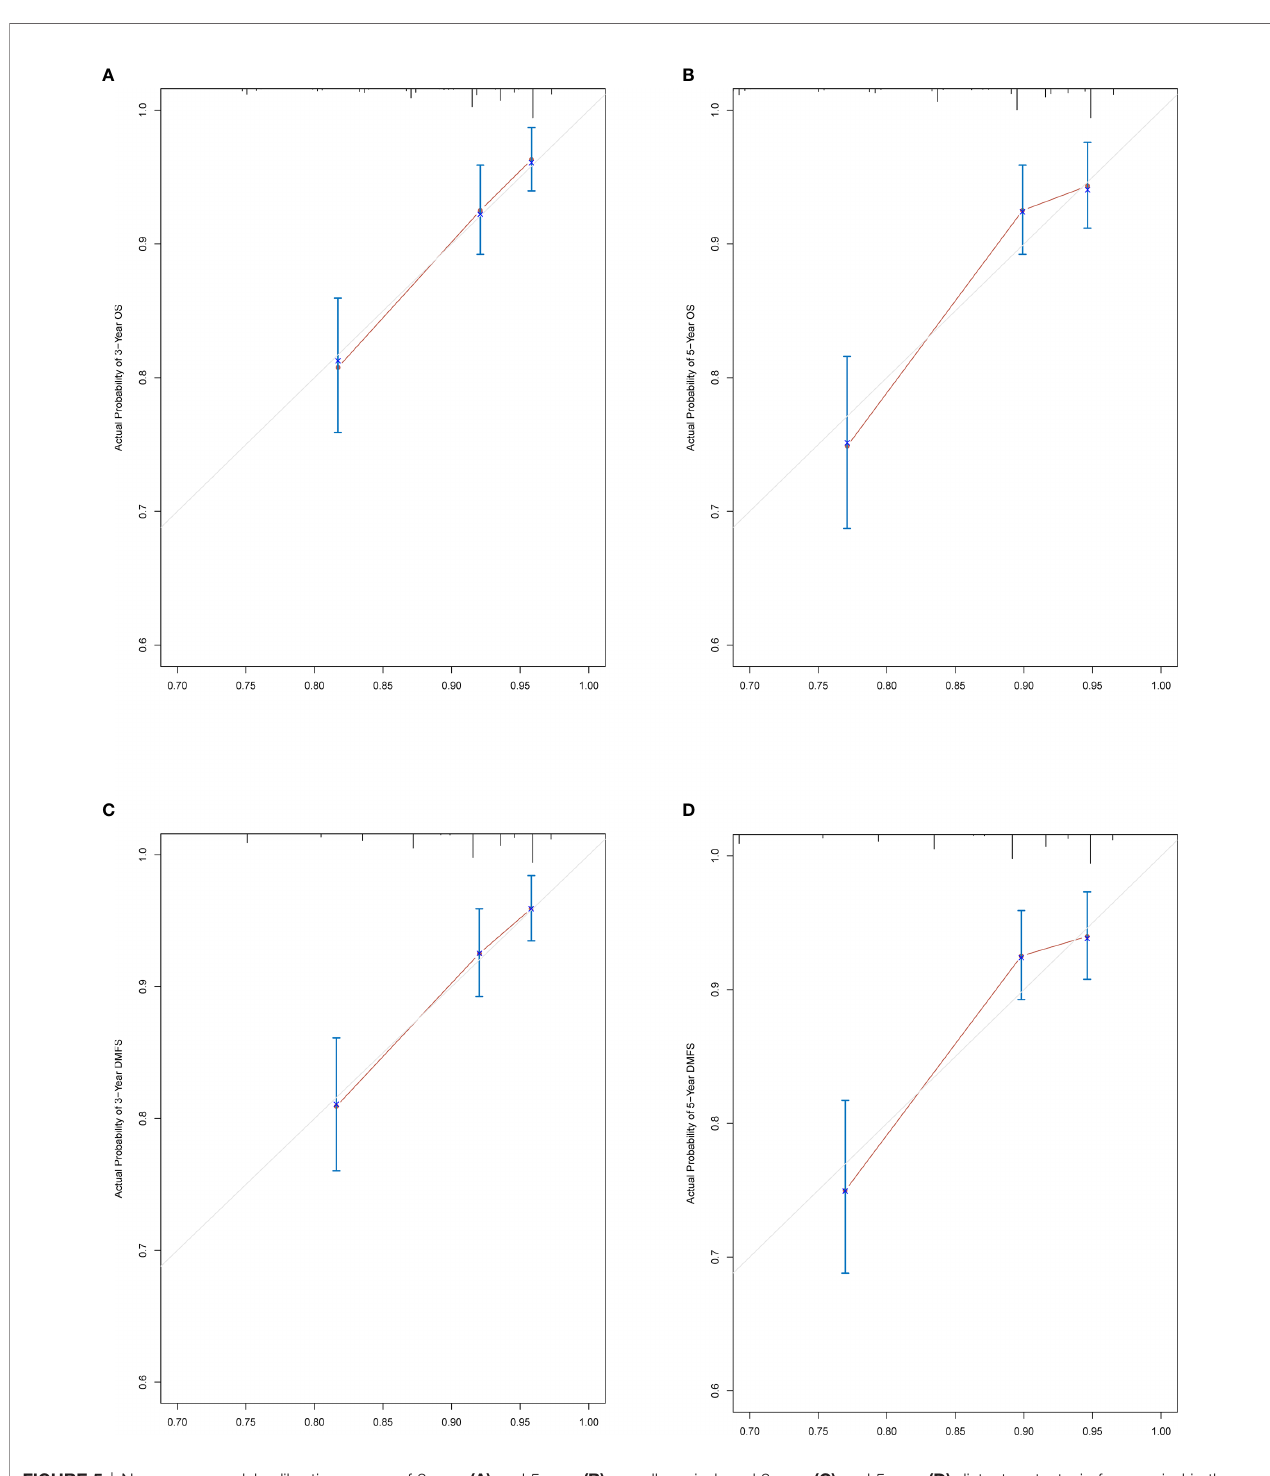
FIGURE 5 | Nomogram model calibration curves of 3-year (A) and 5-year (B) overall survival, and 3-year (C) and 5-year (D) distant metastasis-free survival in the training